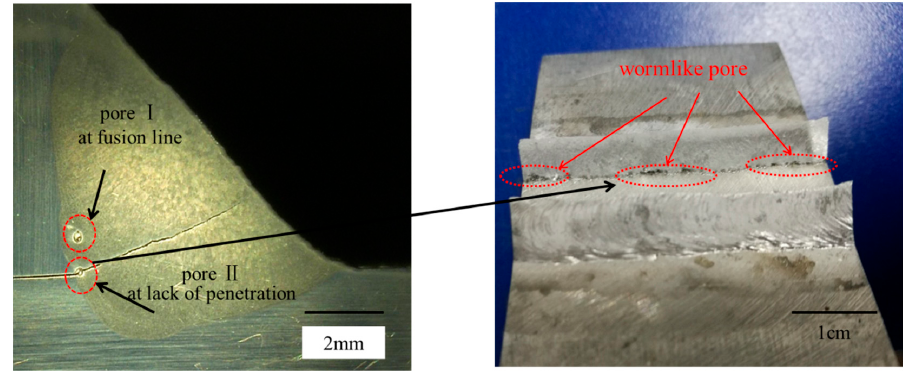
Figure 10. Porosity distribution in T-joint.